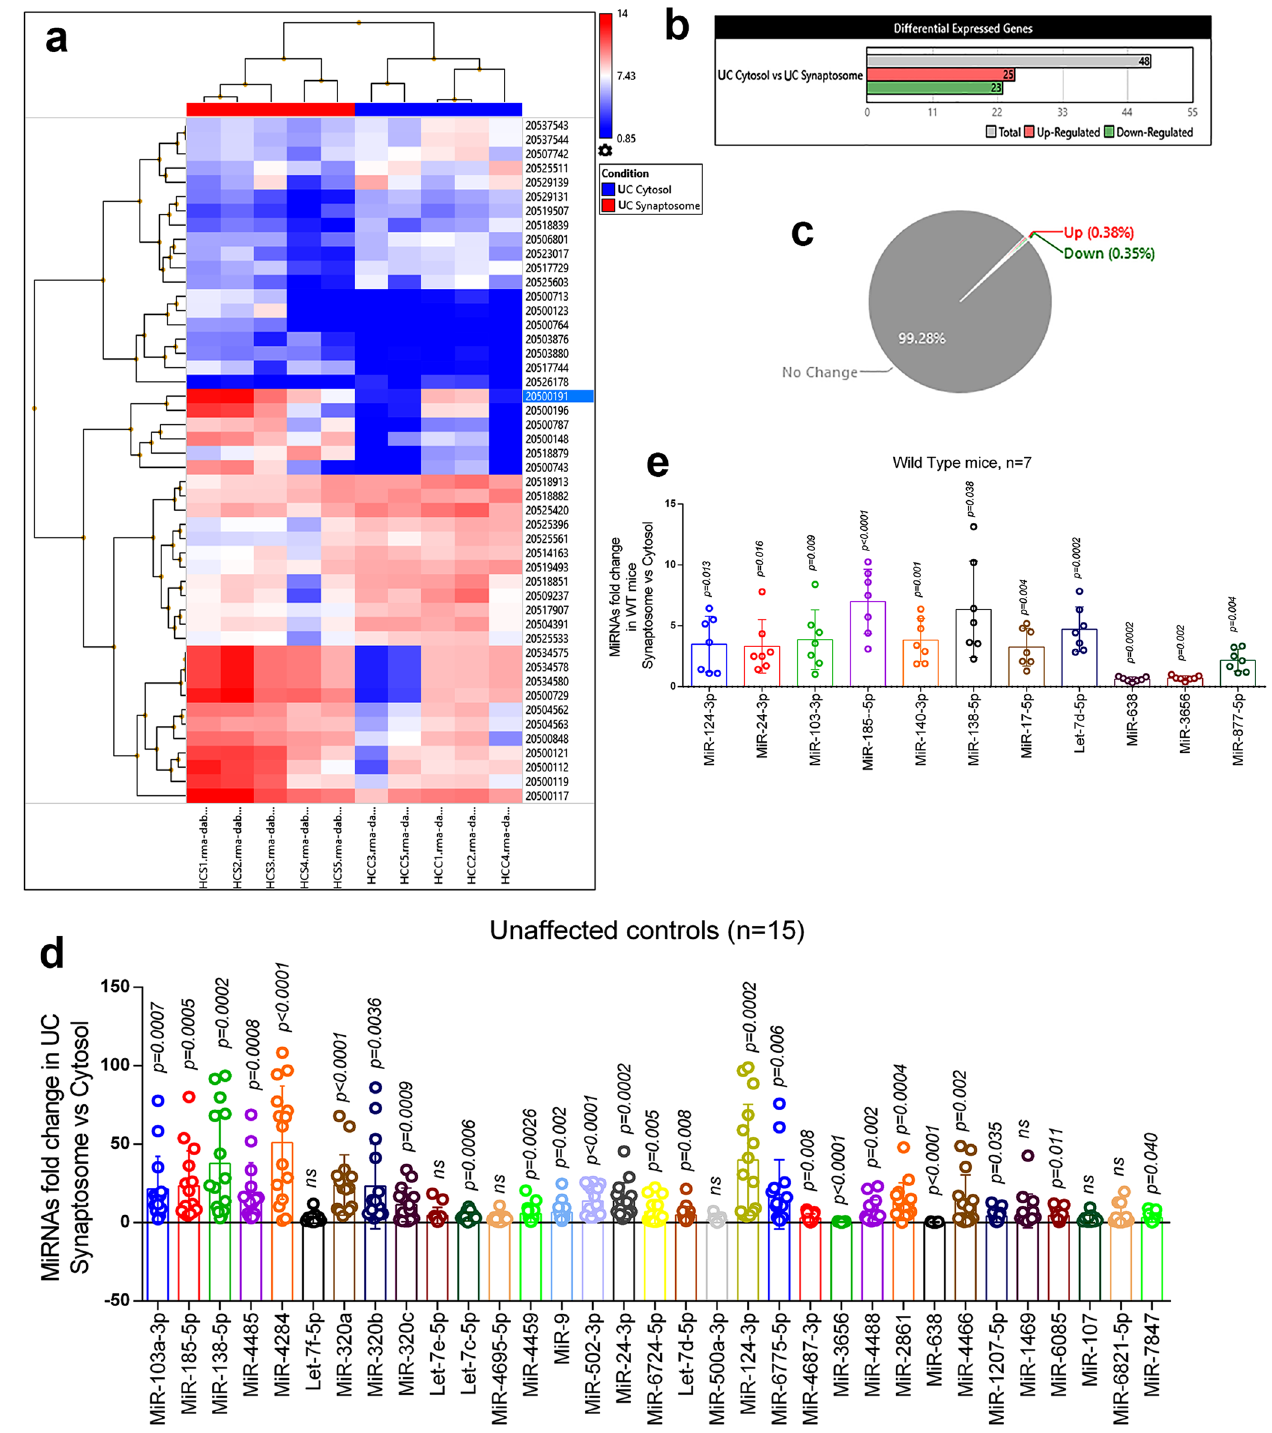
Fig. 2 MiRNAs expression in synaptosome and cytosol in a healthy state. a Hierarchical clustering and heatmap of signi fi cantly deregulated miRNAs in the synaptosome and cytosol of unaffected controls. (red color intensity showed the miRNAs upregulation and blue color intensity showed the miRNAs downregulation). b Total number of miRNAs deregulated in cytosol vs synaptosome in unaffected controls. (grayscale bar — total number of miRNAs; red scale bar — upregulated miRNAs; green scale bar — downregulated miRNAs). c Pi diagram showed the total miRNAs pool distribution and percentage of miRNAs population changed in cytosol and synaptosome in unaffected controls. d qRT-PCR- based validation analysis of signi fi cantly deregulated miRNAs in unaffected controls ( n = 15). MiRNAs expression was quanti fi ed in terms of fold changes in unaffected controls synaptosomes compared to the cytosol. Each circle dot represents one sample. e Validation analysis of signi fi cantly deregulated mmu-miRNAs in WT mice ( n = 7). MiRNAs expression was quanti fi ed in synaptosome relative to the cytosol. Each circle dot represents one animal. Values in the bar diagrams are mean ± SEM and error bars are equivalent throughout the fi gure ( e , d